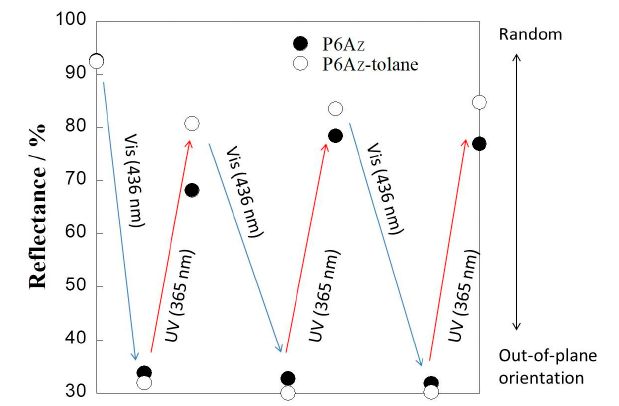
Figure 13. Reflectance change of the P6Az / PVA 20-multi-bilayered film and P6Az–tolane / PVA